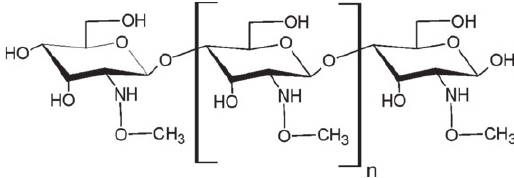
Figure 1 Structure of chitin oligomers (n = number of chitin